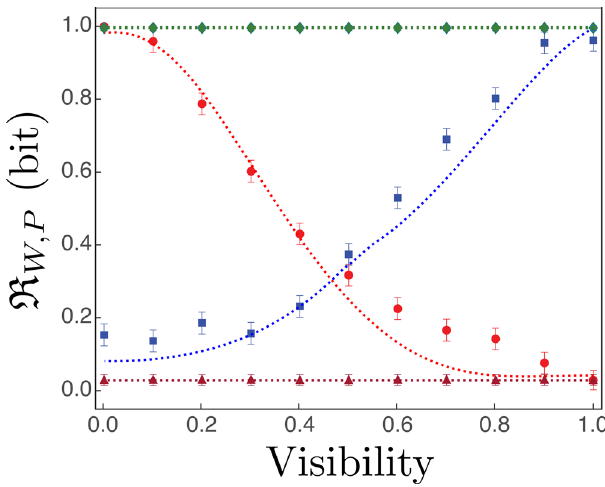
Fig. 2 Wave and Particle Realism as a function of the Visibility. The green diamonds and dark red triangles are the measured R W (wave realism) and R P (particle realism), respectively, inside of the interferometer with the arrangement in Fig. 1a (quantum delayed-choice experiment). The blue squares and red circles are the measured R W and R P , respectively, inside of the interferometer of Fig. 1b (quantum-controlled reality experiment). The symbols represent the experimental results and the dashed lines are numerical calculations that simulate the pulse sequences on the initial experimental state. The data is parametrized by the visibility at the end of the interferometer. The error bars were estimated via Monte Carlo propagation (see Error Analysis subsection in Methods for further details). The error bars for data represented as green diamonds are smaller than the